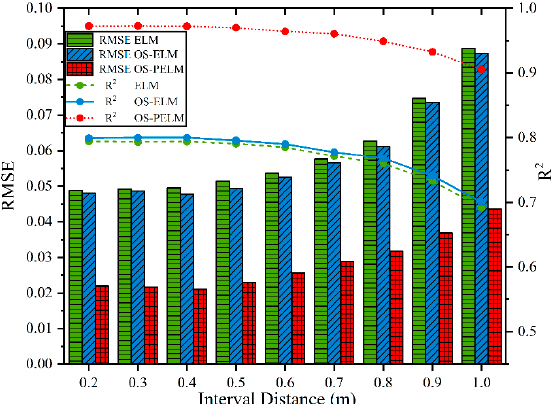
Figure 15. The interval distance vs. the performance indicators of the three models.